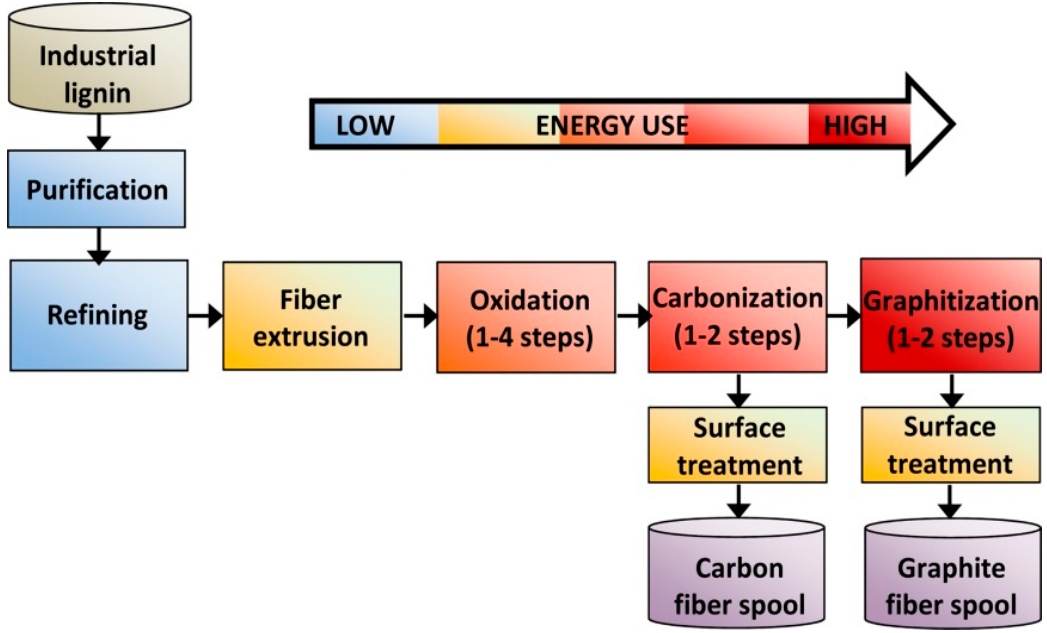
Figure 11. A schematic of carbon fiber production from an industrial lignin. Reprinted from [74] with permission from Wiley © 2020.